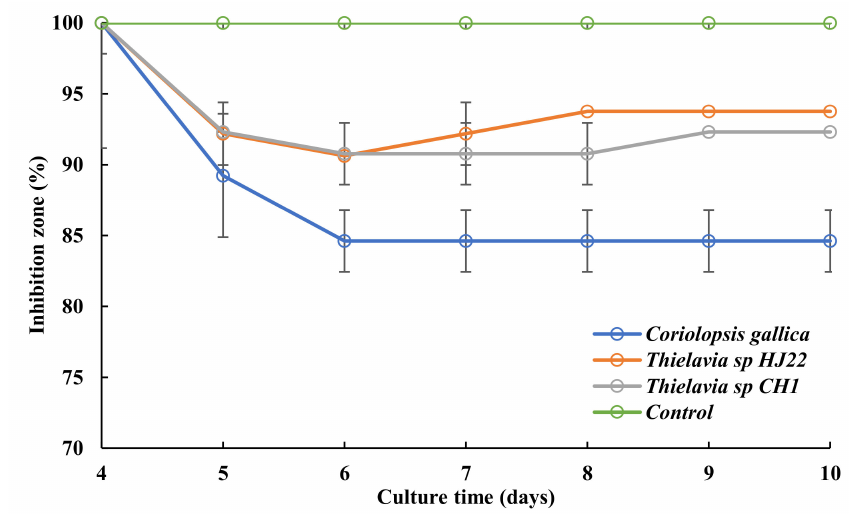
Figure 2. Decrease in inhibition-zone diameter from Day 4 to Day 10 of culture for the 3 fungal strains in media containing levofloxacin at 50 mg L − 1 : Coriolopsis gallica (blue), Thielavia sp. (HJ22) (orange), Thielavia sp. (CH1) (grey), and antibiotic control in M7 medium (green). 100% refers to the levofloxacin inhibition for medium containing levofloxacin and without fungus. Each datapoint (mean ± standard deviation) is the result of triplicate experiments.